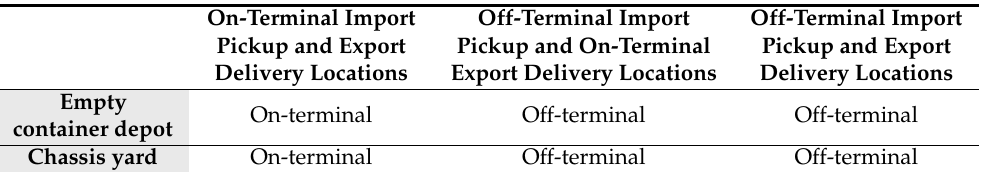
Table 7. The best locations for placing empty container depot and chassis yard according to locations of import pickup and export